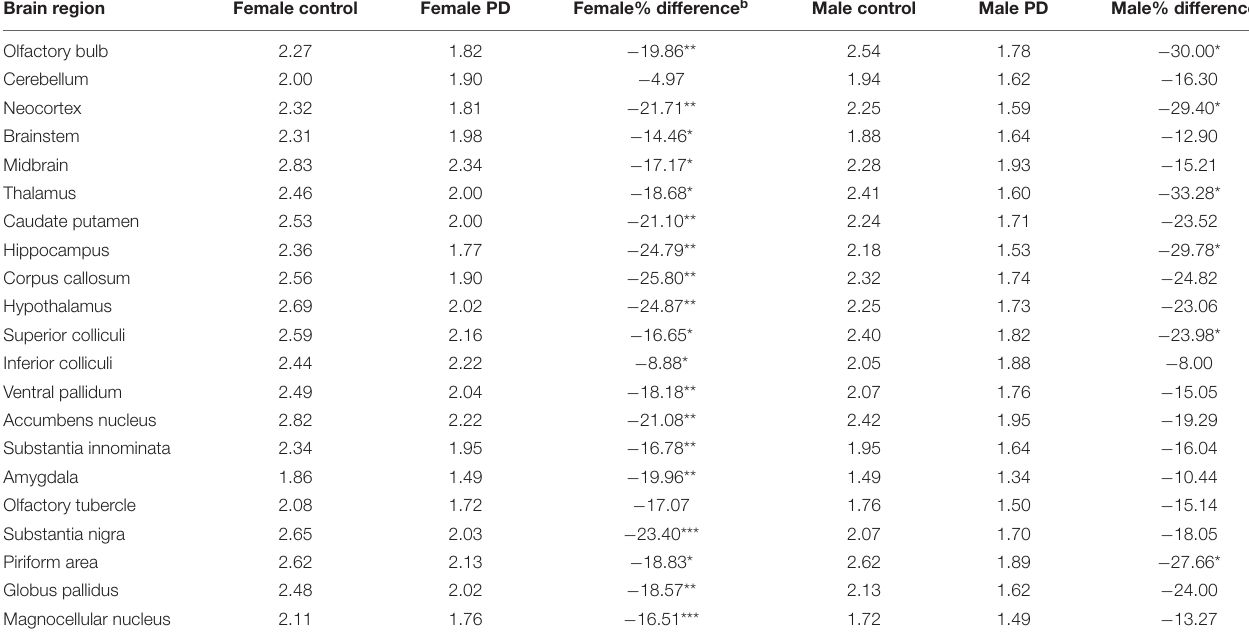
TABLE 1 | [ 18 F]FDG brain region SUV and percent change in A53T PD mice a